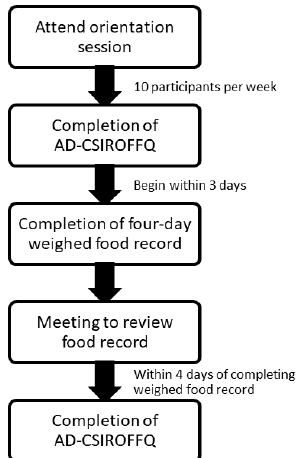
Figure 1. Schematic of the study design. AD-CSIROFFQ, (Alzheimer’s disease-Commonwealth Scientific and Industrial Research Organisation Food Frequency Questionnaire).